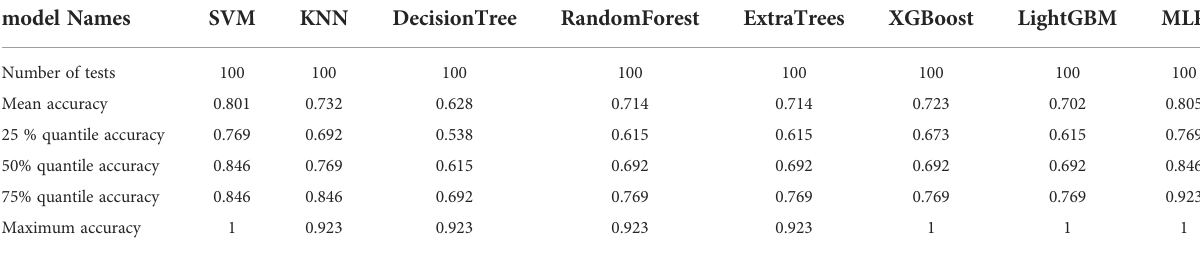
TABLE 15 Distribution of the accuracy of each model randomly tested 100 times by eight common machine learning algorithms. model